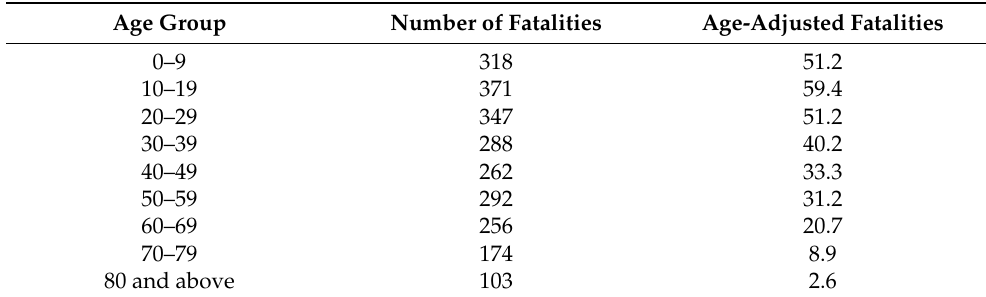
Table 6. Flood fatalities by gender.